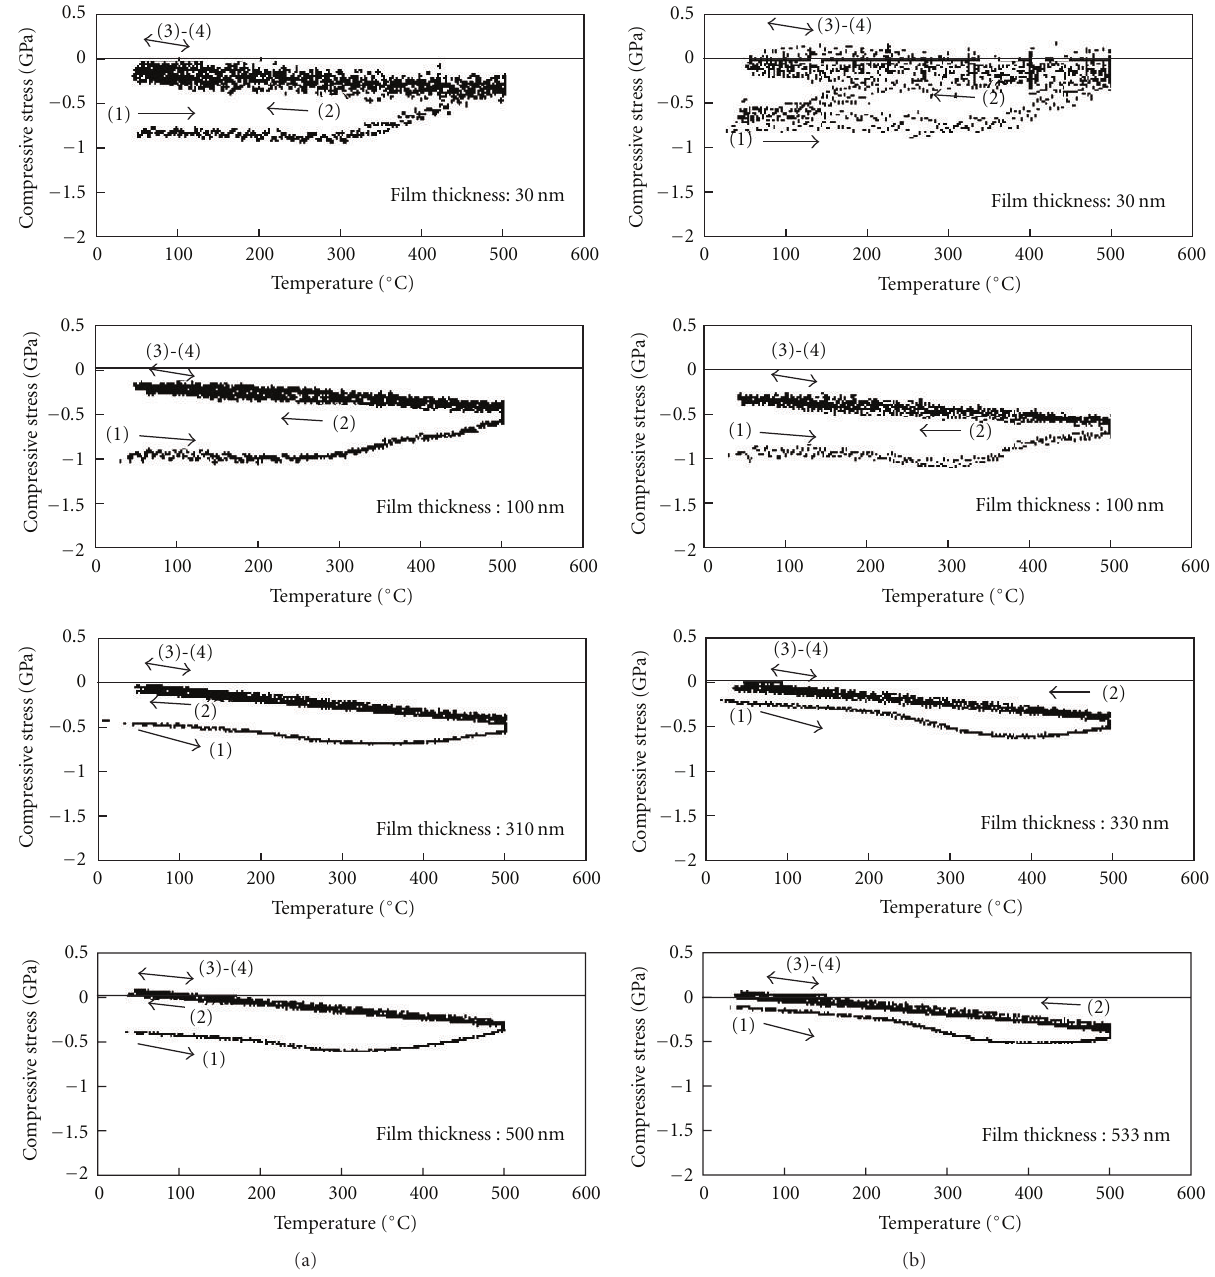
Figure 5: Residual stress behavior during heat-cycle testing (room-temperature: − 500 ◦ C) in an atmosphere of flowing Ar gas for GZO films formed by the magnetron sputtering system. The columns (a) and (b) correspond to changes in the residual stress during heat-cycle testing,